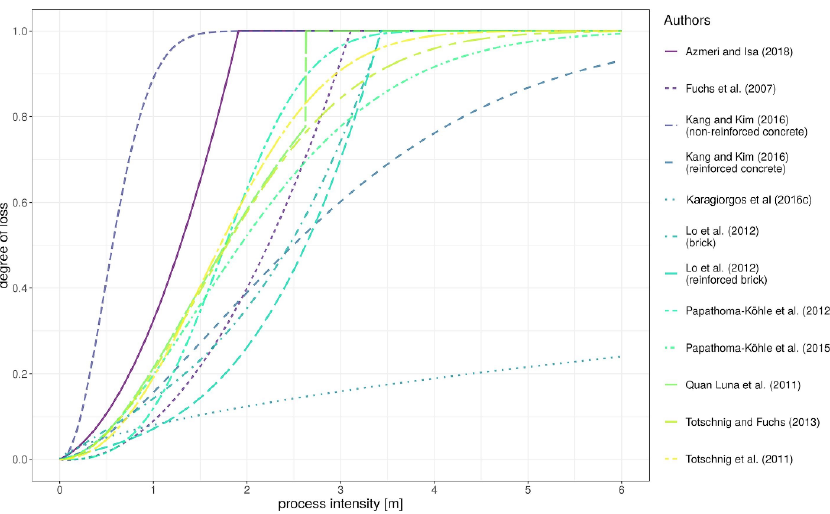
Figure 6. Comparison of the physical vulnerability curves